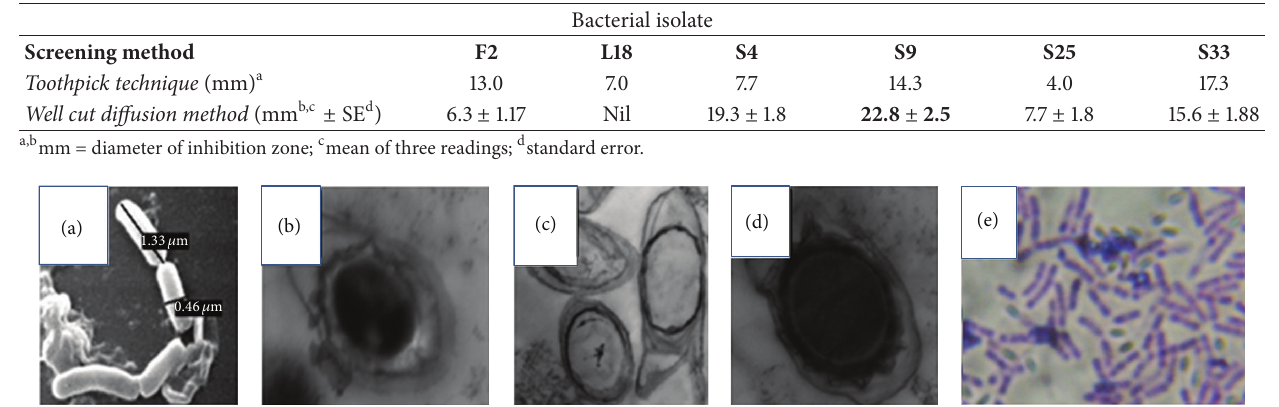
Table 1: Sensitivity of E . amylovora to antimicrobial agents produced by six bacterial isolates.